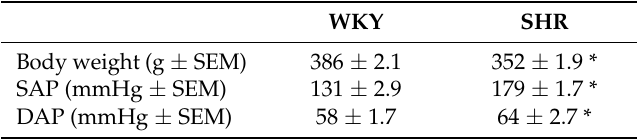
Table 1. Mean values of body weight, systolic arterial pressure (SAP) and diastolic arterial pressure (DAP) in WKY and SHR rats. The differences between WKY and SHR were significant when a Student’s t -test was applied (* p <